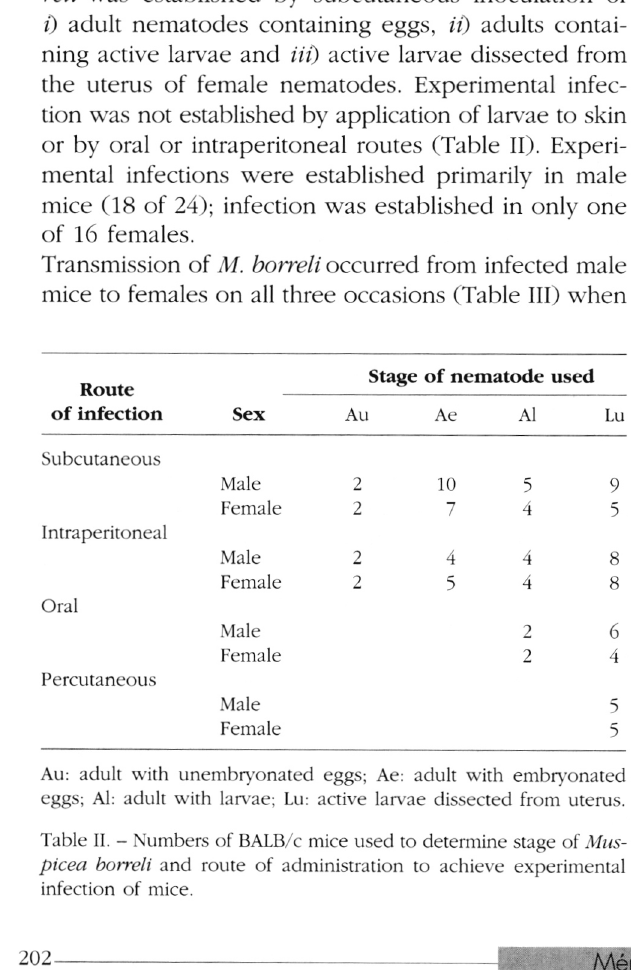
Table III. - Experimental infection of BALB/c mice with Muspicea borreli to test direct transmission from male to female and from female to